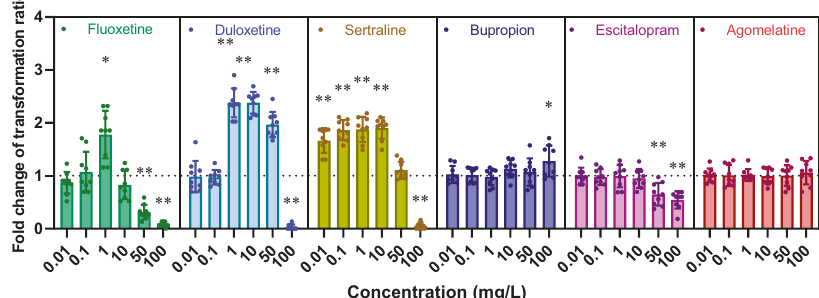
Fig. 1 Antidepressants promote the pWH1266 plasmid transformation into A. baylyi ADP1. Fold change of transformation ratios of A. baylyi ADP1 by plasmid pWH1266 after 6 h treatment of various antidepressants dosages, compared to the untreated control ( n = 9). Signi fi cant differences between individual antidepressant-treated groups and the control groups (0 mg/L) were analysed with ANOVA and shown with * ( p adj < 0.05), ** ( p ad j < 0.01). P values were corrected by the Benjamini/Hochberg